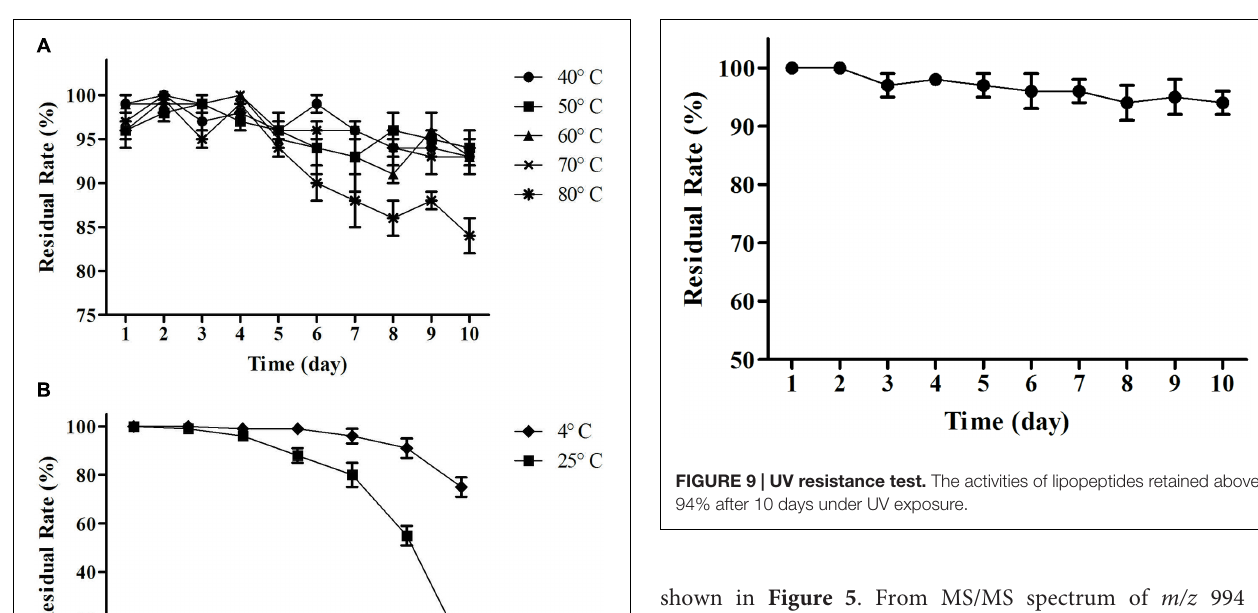
shown in Figure 5 . From MS/MS spectrum of m/z 994 in Figure 5A , [M + H] + m/z 976.53 was the dehydration ion peak [M-H 2 O] + of m/z 994 and 112.34 (994 – 881.66 = 112.34) was exactly the fragment ion mass of Leu/Ile (b8). Starting from the b + end, b + ions fragments in order were 441.05